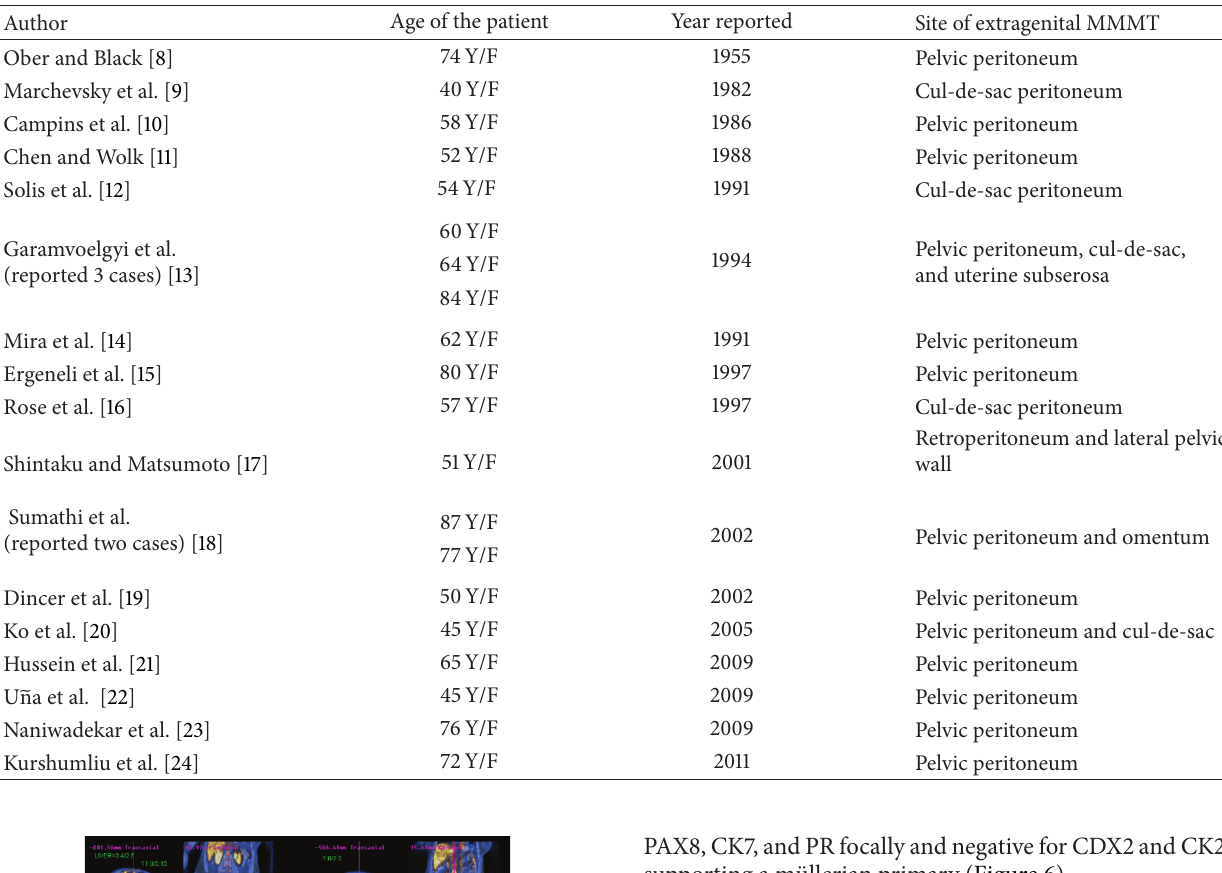
Table 1: Cases of MMMTs reported in the pelvic peritoneum and cul-de-sac.